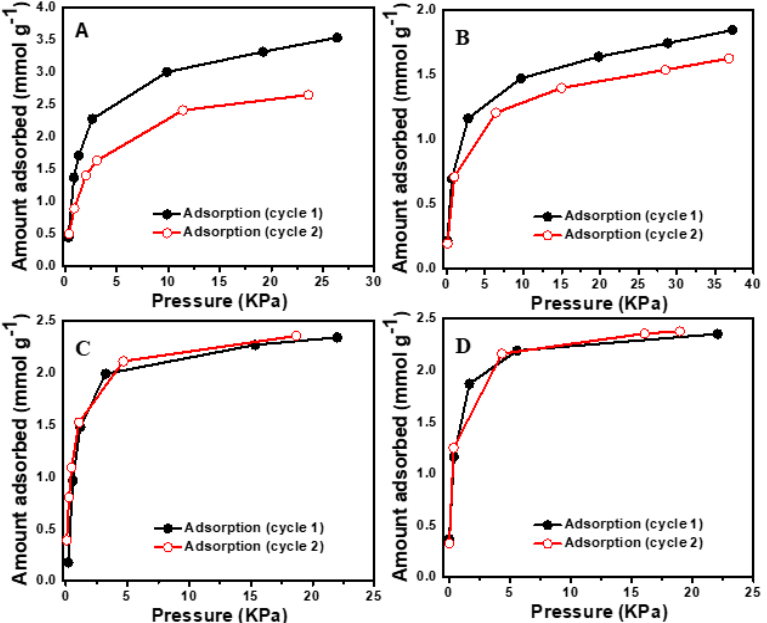
Figure 4. Adsorption (cycle-1) and re-adsorption (cycle-2) of propene on SAPO-34 zeolites with different acidic strengths: ( A ) strong acidity at room temperature (RT), ( B ) moderate acidity at RT, ( C ) weak acidity at RT, and ( D ) strong acidity at 0 °C.